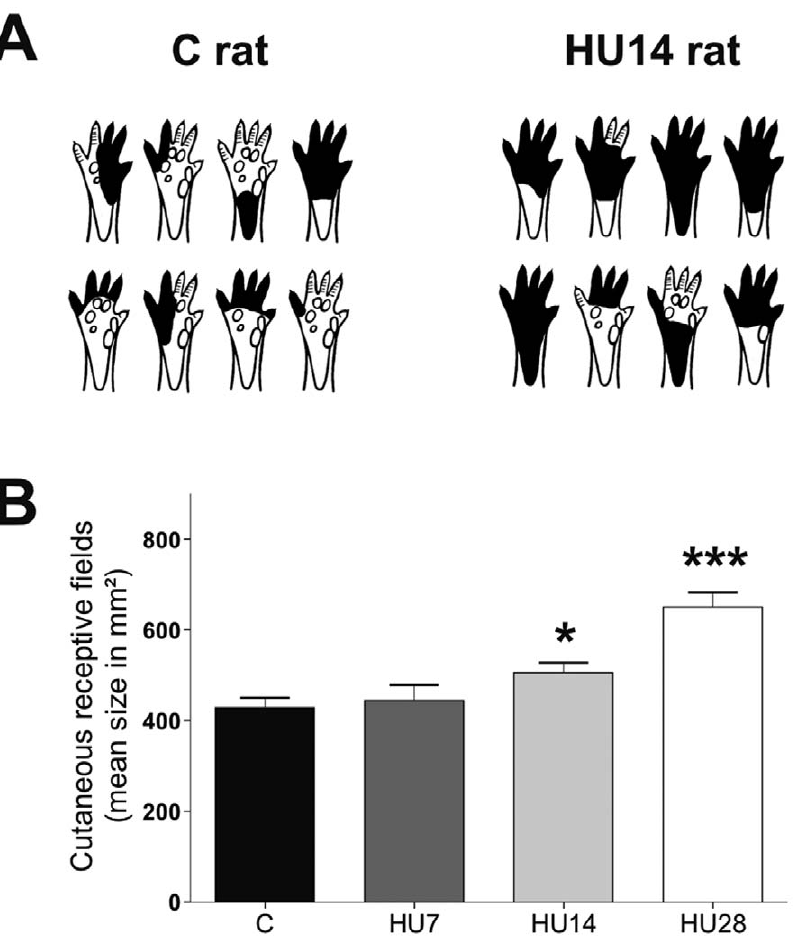
Figure 2. Hindlimb unloading induces an extension of the cutaneous RF size. (A) Illustration of a sample of cutaneous RF for one C and one HU14 rats, obtained at the penetration sites presented in figure 1 ( white dots ). Only the ventral surface [42] of the hindpaw is presented. (B) Cutaneous RF mean size (mm 2 ) for C and HU-x groups.